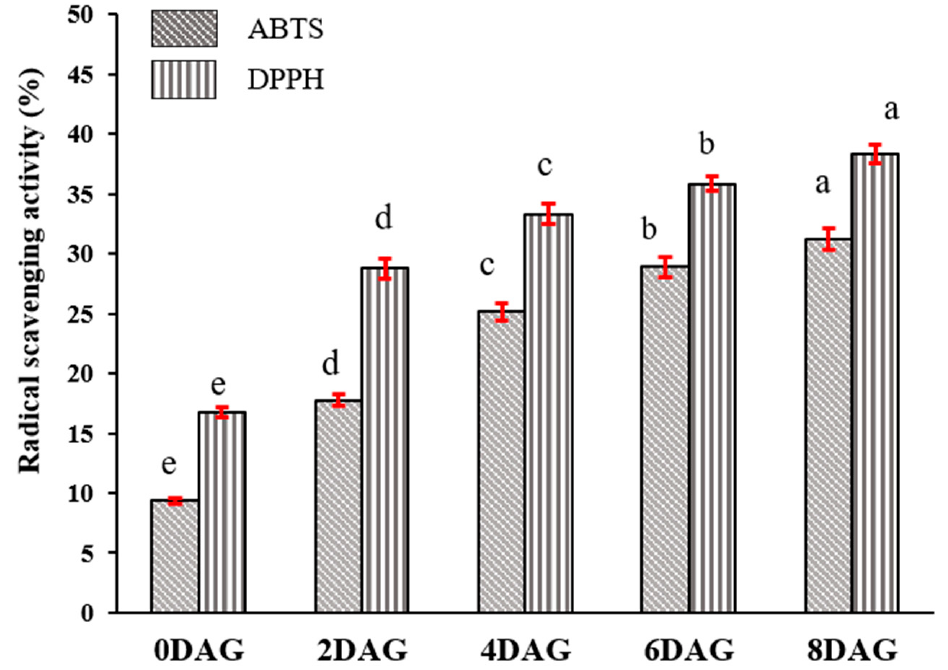
Figure 7. Antioxidant activity (ABTS and DPPH assays) of sacha inchi seeds at different germination times ( p ≤ 0.05). ABTS, 2,2-azobis(3-ethylbenzothialzoline-6-sulfonic acid; DPPH, 2,2-diphenyl-1- picrylhydrazyl; DAG, days after germination. Means followed by different letters are significantly different ( p ≤ 0.05) according to the Duncan’s new Multiple Range